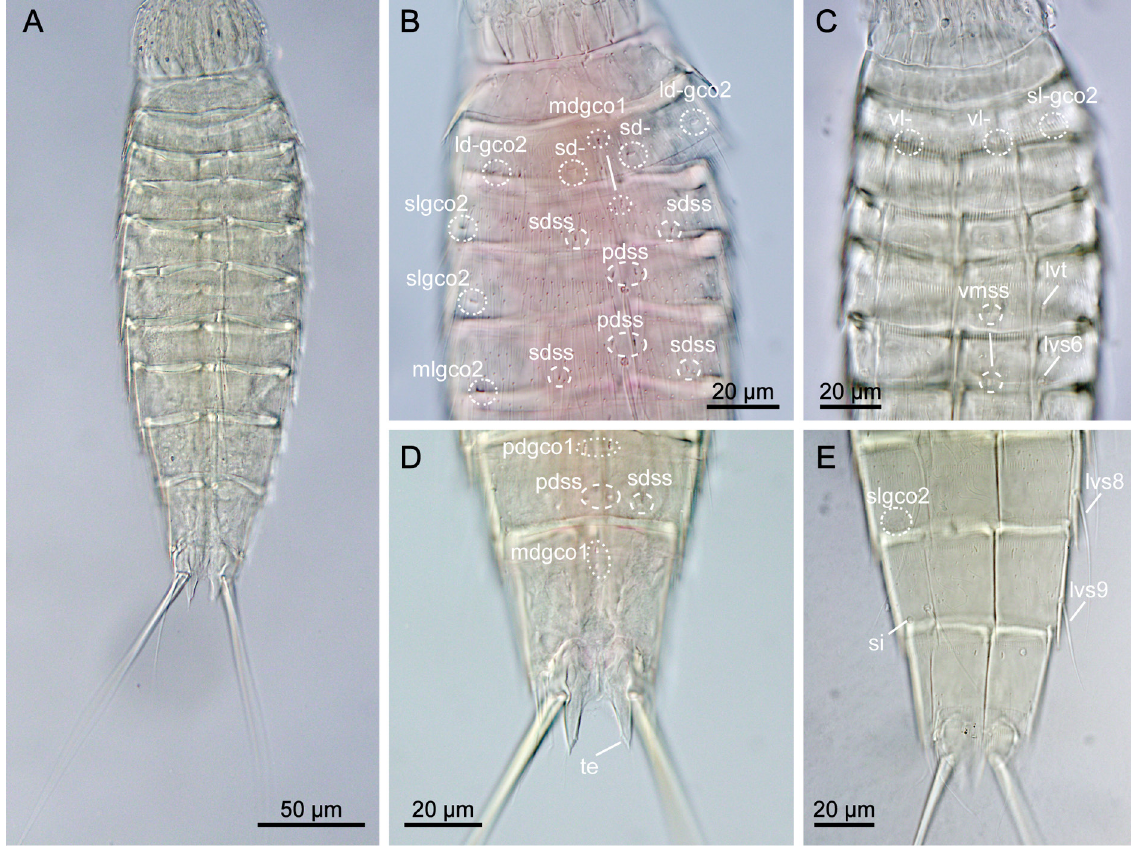
Fig. 38. Light micrographs showing overview and details of Echinoderes juliae Sørensen et al ., 2018. A, C . ♀ (NHMD- 921719). B, D . ♂ (NHMD- 921729). E . ♂ (NHMD- 921721). A . Dorsal overview. B . Segments 1 to 5, dorsal view. C . Segments 1 to 6, ventral view. D . Segments 9 to 11, dorsal view. E . Segments 8 to 11, lateroventral view. Abbreviations: see Material and